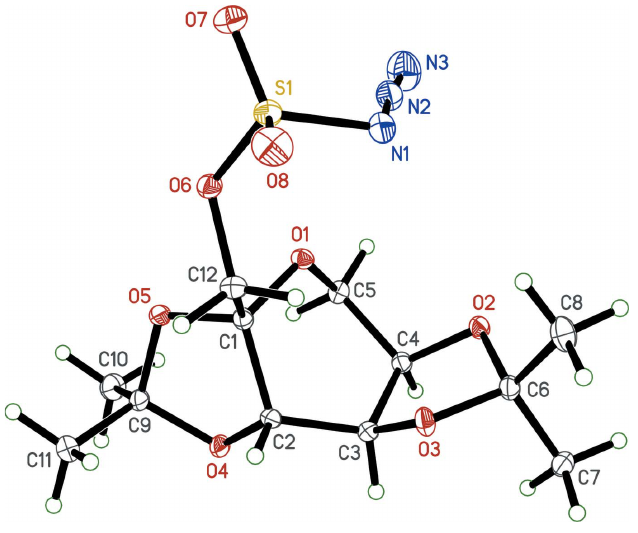
Figure 1 An ellipsoid plot of I (50% probability) for the structure at 90 K. The structure at 298 K is essentially unchanged, other than having much larger